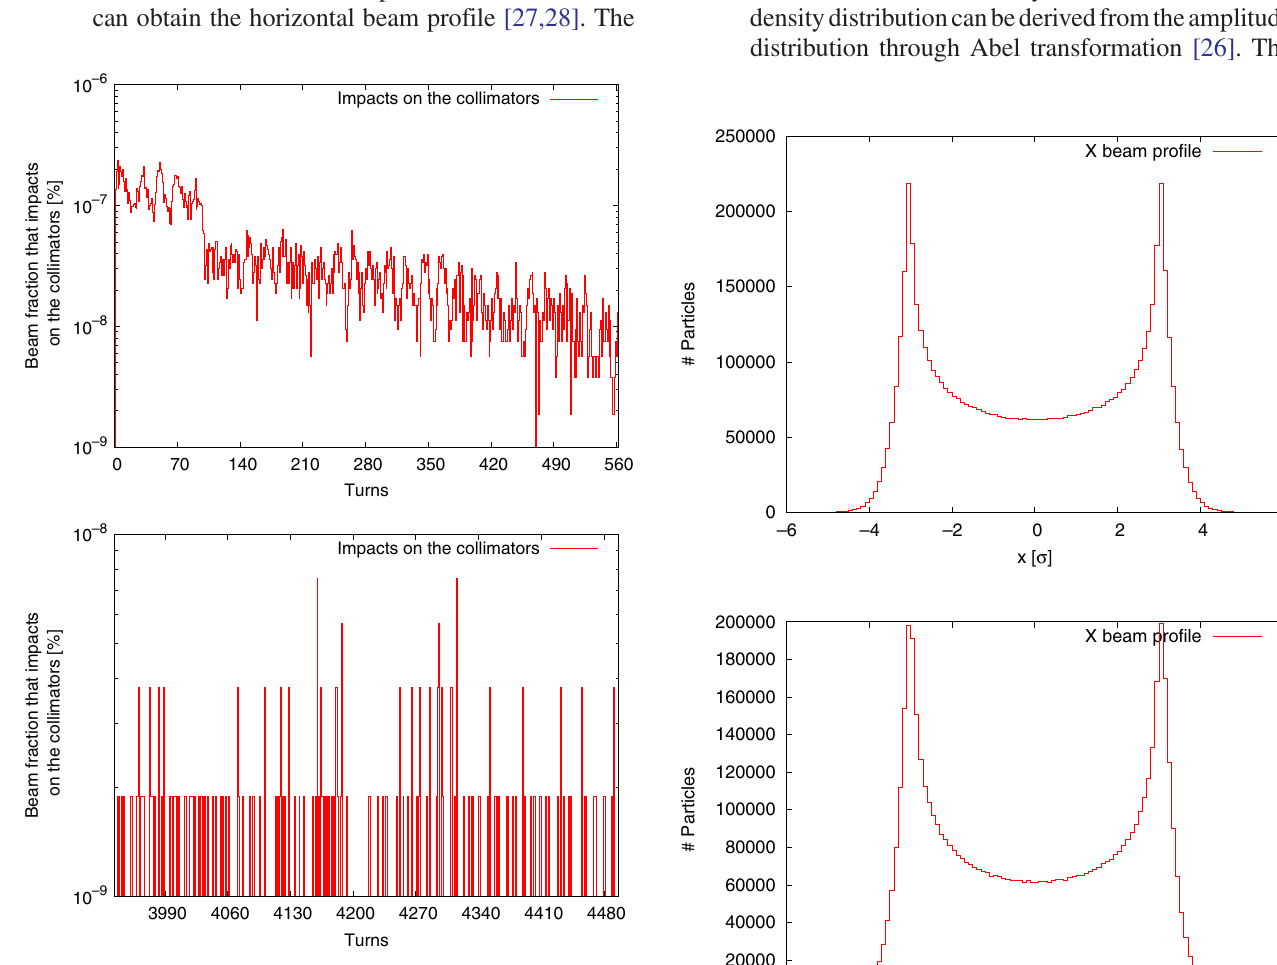
FIG. 4. Histograms of the total beam fraction that impacts on the collimators for the first and eighth synchrotron periods (562 LHC turns) to reach a quasistationary-state for beam distribution SG II. For the first synchrotron period (top) the average beam fraction that impacts on the collimators is 2 . 37 × 10 − 5 % and for the last synchrotron period (bottom) is 3 . 82 × 10 − 7 %.